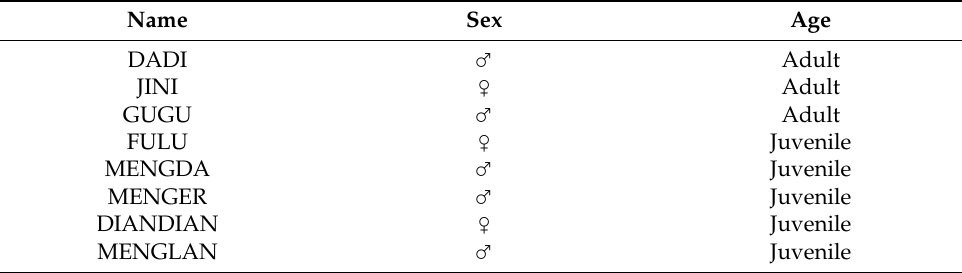
Table 1. Information on giant pandas at the Beijing